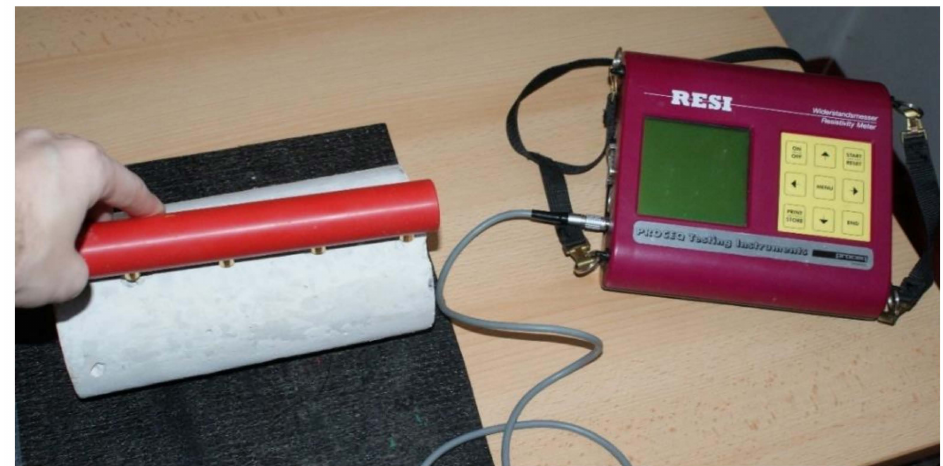
Figure 2. A Wenner probe before the